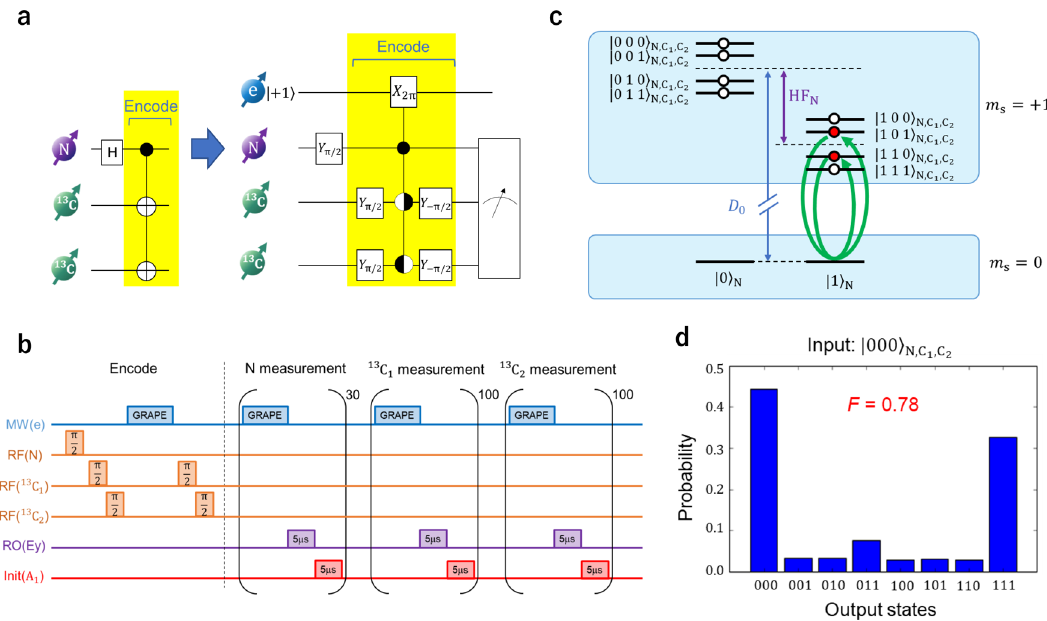
Fig. 2 Three-qubit entanglement generation. a Quantum circuit for entanglement generation between three nuclear spins, one nitrogen, and two carbon isotopes. This is equivalent to the quantum circuit of encoding in three-qubit quantum error correction in Fig. 3. H, X, and Y, respectively, denote Hadamard, Pauli-X, and Pauli-Y gates. b Pulse sequence in the experiment. Nuclear spin manipulation is performed by radiofrequency (RF), and the geometric phase manipulation between the electron (e), nitrogen (N), and carbon (C) is performed by microwaves (MW) using the GRAPE algorithm. RO, Init, E y , and A 1 , respectively, denote readout, initialize and two orbital excited states. c Conceptual diagram of the holonomic controlled-phase gate in the encoding. The π phase is given to j 110 i N ; C and j 101 i N ; C . D 0 is the zero- fi eld splitting and HF N is the hyper fi ne (HF) splitting between the electron and 1 ; C 2 1 ; C 2 the nitrogen. d Classical evaluation of the GHZ entanglement generation for three qubits. Correlations are con fi rmed by measuring the z axis for all nitrogen and carbon nuclear spins. Since the quantum correlation of three qubits can be measured with the same technique as the quantum correlation of two qubits, it was not measured in consideration of the experimental